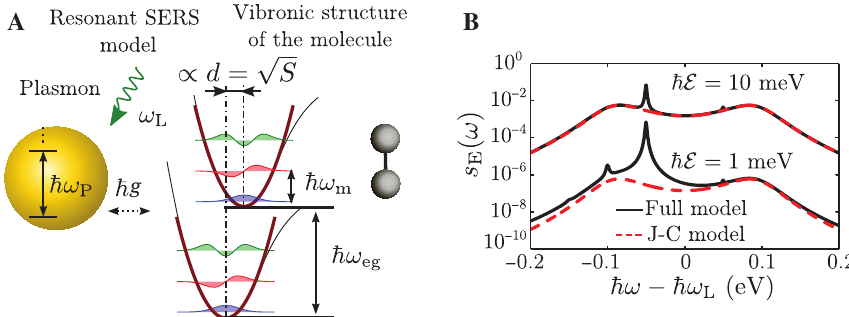
Figure 2: Schematics of the system considered for the description of SERRS alongside with examples of inelastic SERRS and Jaynes- Cummings spectra. (A) Schematic depiction of the system where a plasmonic mode interacts with the electronic states of the molecule, which are further coupled to molecular vibrations. A dye molecule with an excitonic transition of energy ħ ω is placed into a plasmonic cavity that supports a eg = ħ ω resonance at energy ħ ω tuned to the molecular transition ( ħ ω ). Each molecular electronic level serves as a potential energy surface pl pl eg (PES) supporting a vibrational mode of energy ħ ω . The excited state and the ground state PES are mutually displaced as given by the m dimensionless displacement d . The plasmon is illuminated by a single intense laser of frequency ω and pumping amplitude ℰ that triggers L the surface-enhanced Raman scattering process. (B) Two examples of emission spectra calculated using the full model where a vibrational mode is present (black lines) and the J-C model without considering the vibrations (red dashed line) calculated for ħ ℰ = 1 meV and 10 meV. = 2 meV, The spectra in (B) are calculated using the parameters for the J-C model as in Figure 1 and the following values for the vibrations: ħ γ b = 50 meV, and 0.1. S ħ ω m